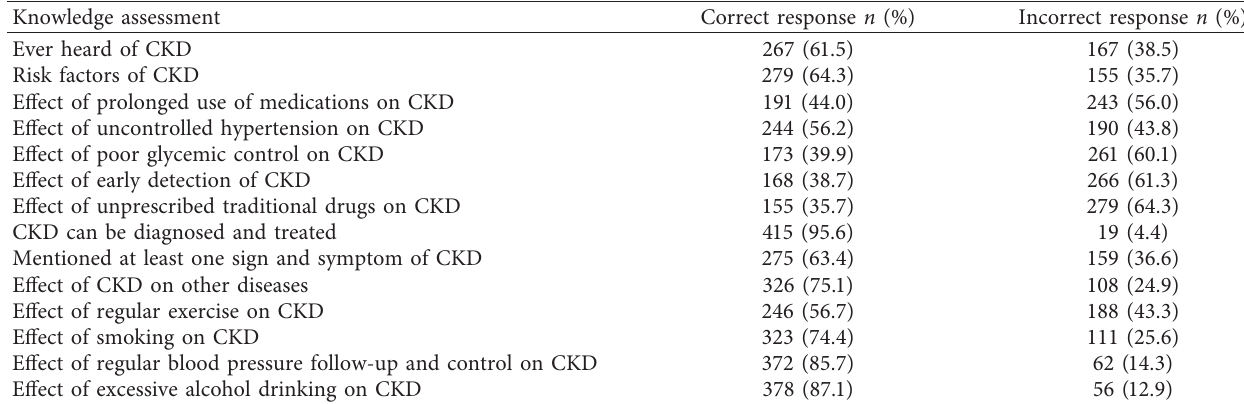
Table 2: Knowledge assessment towards CKD among hypertensive patients at Gondar town in